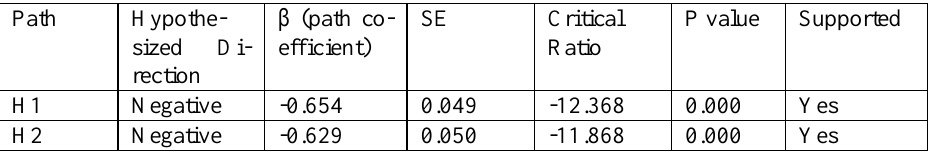
Table 3: Hypotheses testing: AMOS output